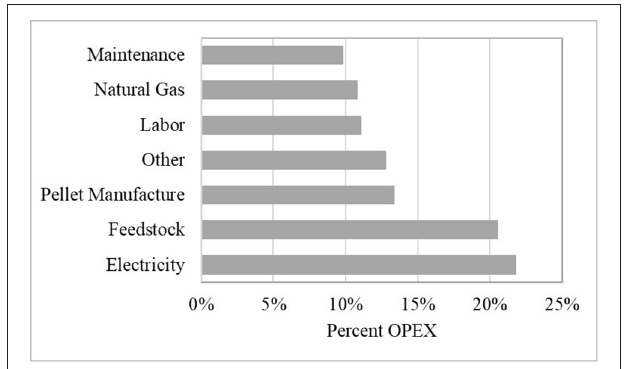
FIGURE 2 | Percentage of operating costs by category for concentrated sugar syrup.